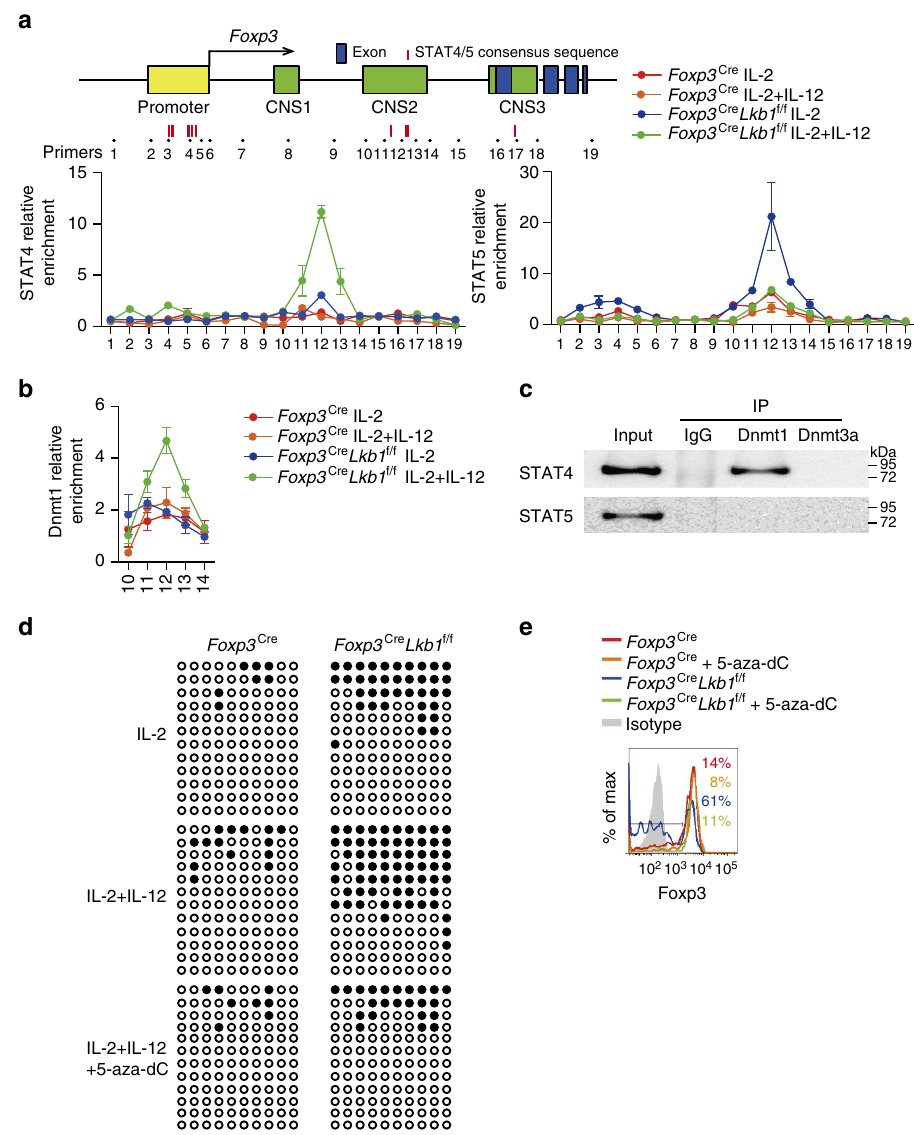
Figure 5 | Lkb1 prevents STAT4 binding to CNS2. ( a ) Binding of STAT4 and STAT5 to the Foxp3 locus in Foxp3 Cre and Foxp3 Cre Lkb1 f/f T reg cells treated with IL-2 or IL-2 plus IL-12, determined by ChIP. ( b ) Binding of Dnmt1 to the CNS2 of Foxp3 locus in Foxp3 Cre and Foxp3 Cre Lkb1 f/f T reg cells treated with IL-2 or IL-2 plus IL-12, determined by ChIP. ( c ) STAT4 and STAT5 coprecipitation with Dnmt1 and Dnmt3a was analysed by using nuclear extract from in vitro expanded T reg cells. ( d ) Methylation of the CpG motifs of the Foxp3 promoter and CNS2 in Foxp3 Cre and Foxp3 Cre Lkb1 f/f T reg cells determined by bisulfite sequencing, and T reg cells were treated with indicated reagents. Filled circles represent methylated CpG sites and open circles represent unmethylated CpG sites. ( e ) Foxp3 expression in Foxp3 Cre and Foxp3 Cre Lkb1 f/f T reg cells co-cultured with DCs supplemented with IL-2 plus IL-12 in the presence or absence of 5-aza-dC. All data are representative of at least two independent